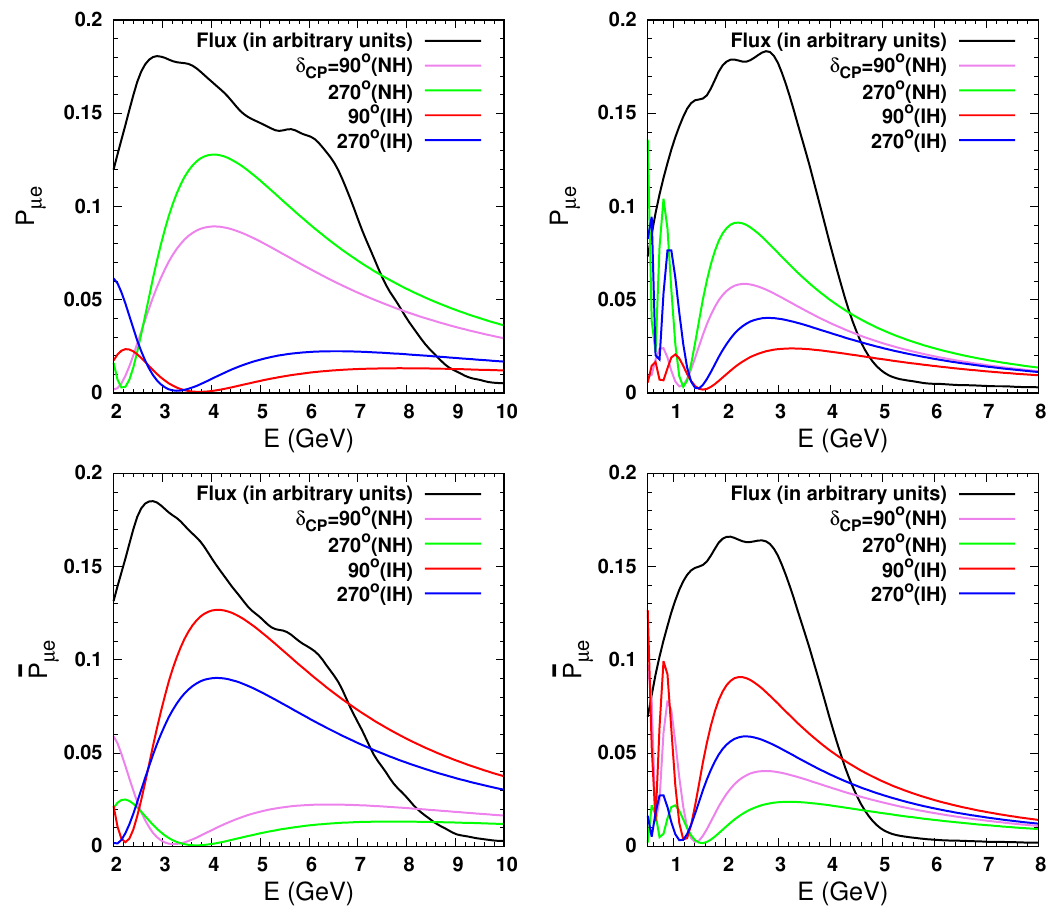
Figure 1 . Appearance channel probability and flux as a function of energy. The left column is for P2O baseline and the right column is for DUNE baseline. In each column the top panel is for neutrinos and the bottom panel is for